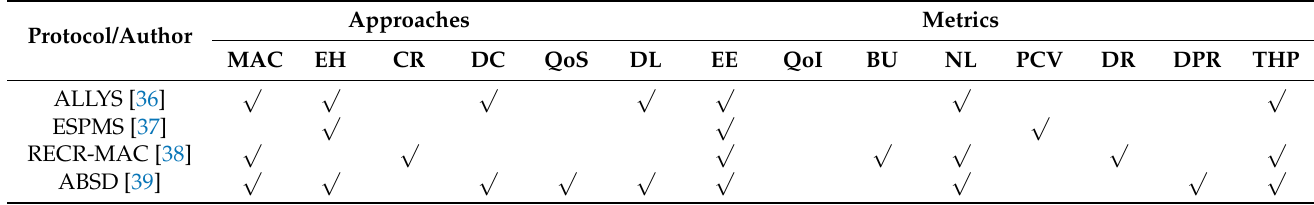
Table 7. Comparative assessment of energy efficient techniques at local processing and storage